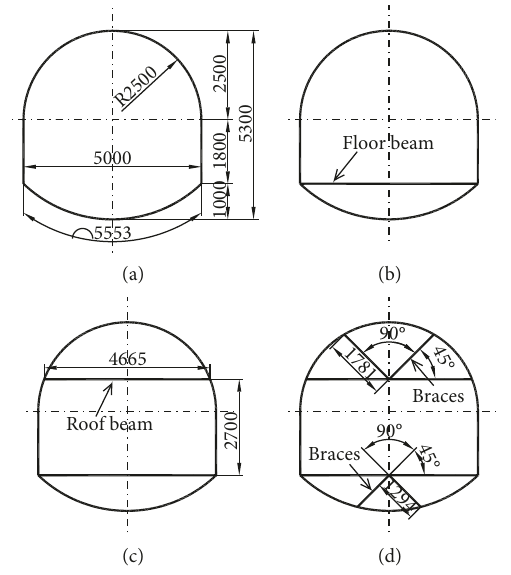
Figure 1: Sets’ patterns and dimensions (units: mm): (a) original set (universally used in situ); (b) floor beam set; (c) RFB set; (d) RFBB set